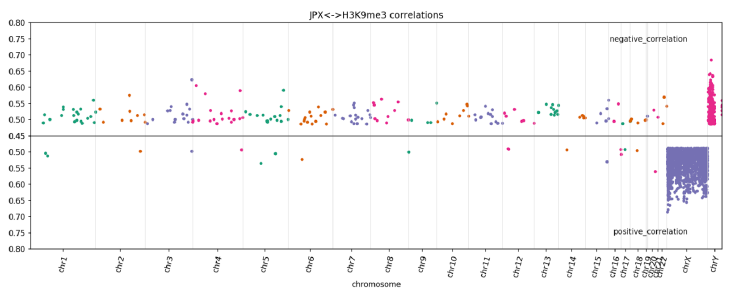
Figure 2. Per chromosomal distribution of lncRNA-correlated peaks of H3K9me3 for